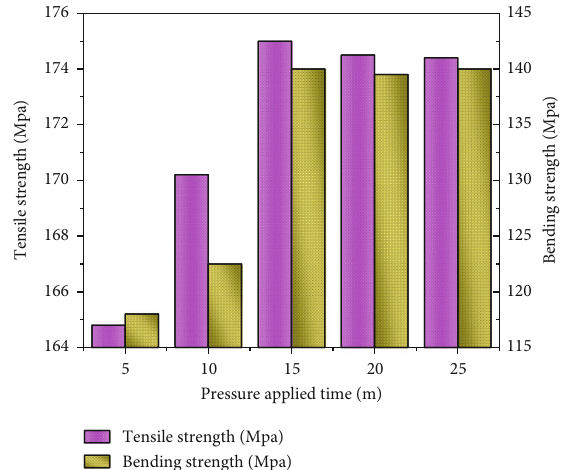
Figure 7: Tensile and bending strength as a function of time applied